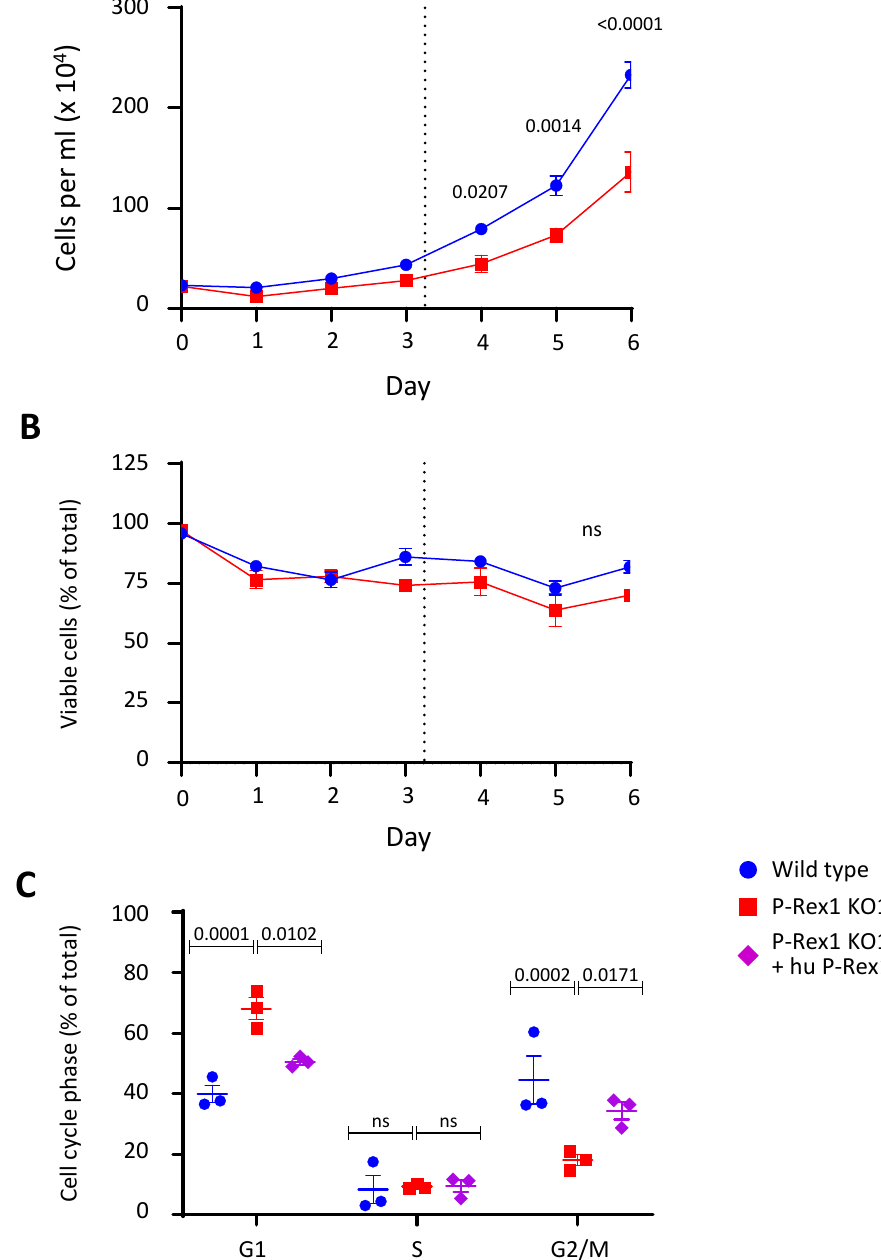
Figure 6. P-Rex1 deficiency reduces PC12-S1PR1 cell proliferation and cell-cycle progression. ( A , B ) P-Rex1 deficiency reduces the growth rate of PC12-S1PR1 cells without affecting cell viability. Wild-type and P-Rex1-deficient PC12-S1PR1 cells were grown in full medium. Aliquots of cells were counted by haemocytometer to assess growth ( A ) or tested by trypan blue exclusion assay for viability ( B ) at the indicated timepoints. Data in ( A , B ) are the mean ± SEM of three independent experiments. Statistical analysis involved two-way ANOVA with Sidak’s multiple comparisons tests. ( C ) P-Rex1 deficiency caused an accumulation of cells in G1 cell-cycle phase. Wild-type and P-Rex1-deficient PC12-S1PR1 cells, as well as P-Rex1-deficient PC12-S1PR1 cells reconstituted with human full-length P-Rex1 (hu P-Rex1), were grown in full medium, fixed and permeabilised in 70% ethanol, and stained with DAPI to determine stages of the cell cycle and levels of apoptosis by flow cytometry. Data are from three independent experiments and are presented as the mean ± SEM; each symbol is one experiment. Statistical analysis involved two-way ANOVA with Sidak’s multiple comparisons test; ‘ns’ denotes nonsignificant